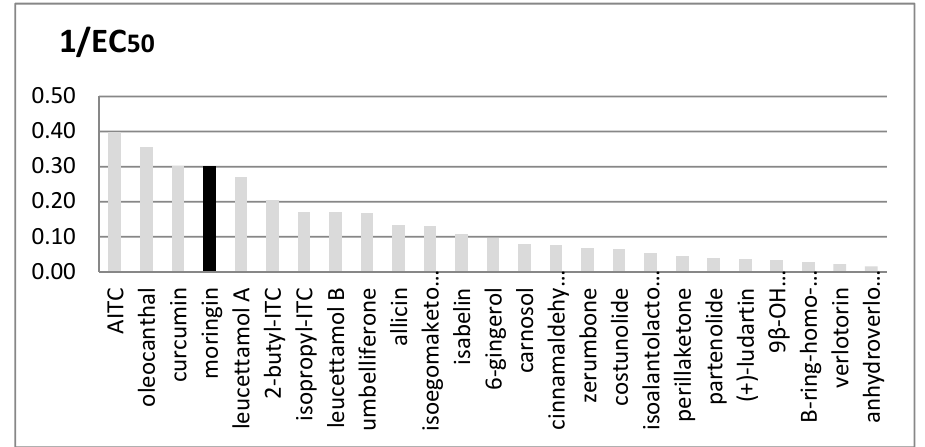
Figure 4. Comparison between in vitro rTRPA1 ′ s activity of many natural known agonists. Potency is expressed as 1/EC 50 ; EC 50 values are given in μ M units. Moringin from Moringa oleifera is shown in black.